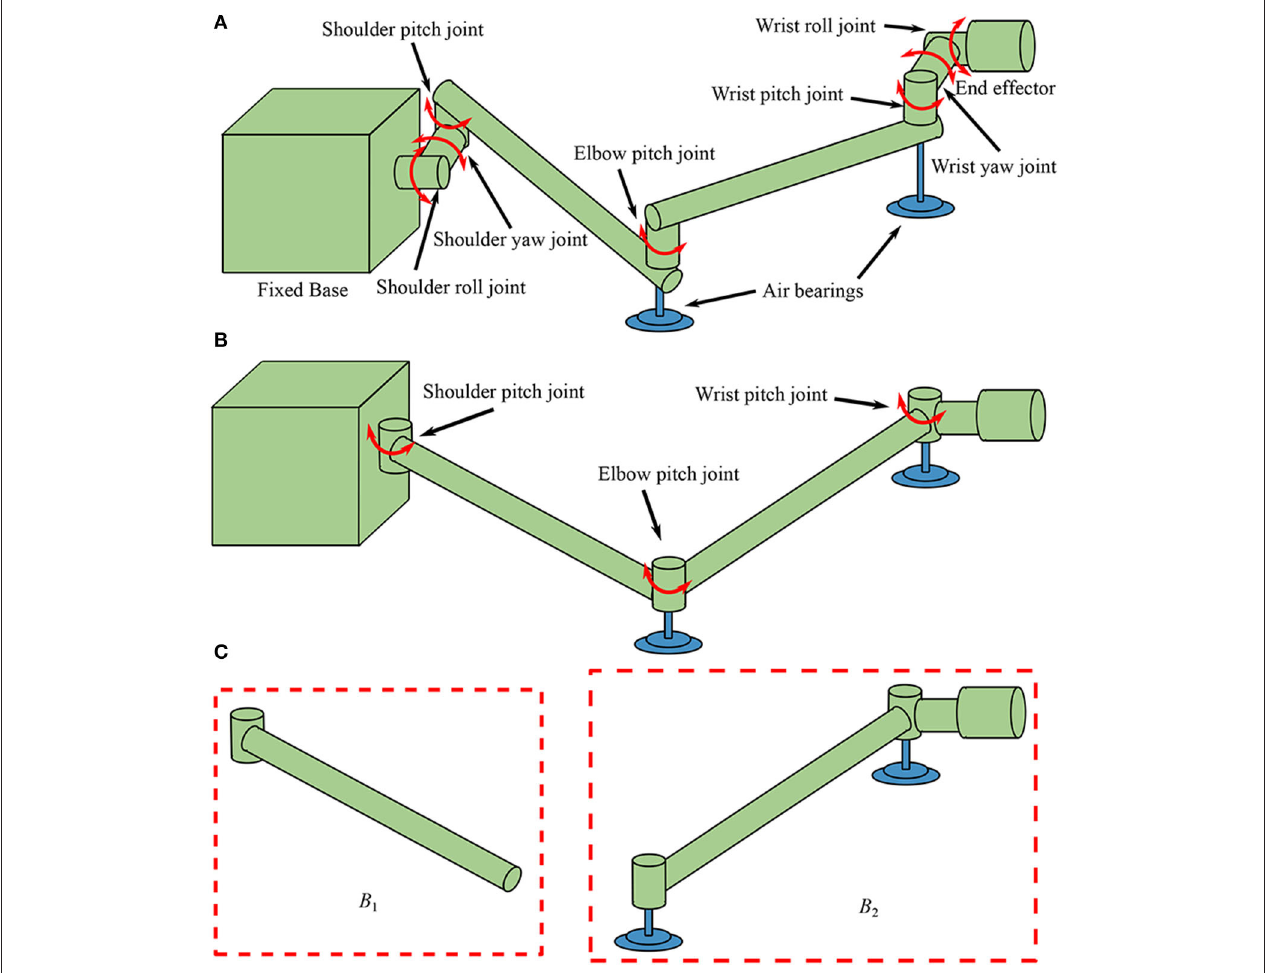
FIGURE 1 | Manipulators used for air bearing test: (A) a 7-DOF manipulator, (B) a reduced equivalent manipulator, and (C) the two composite